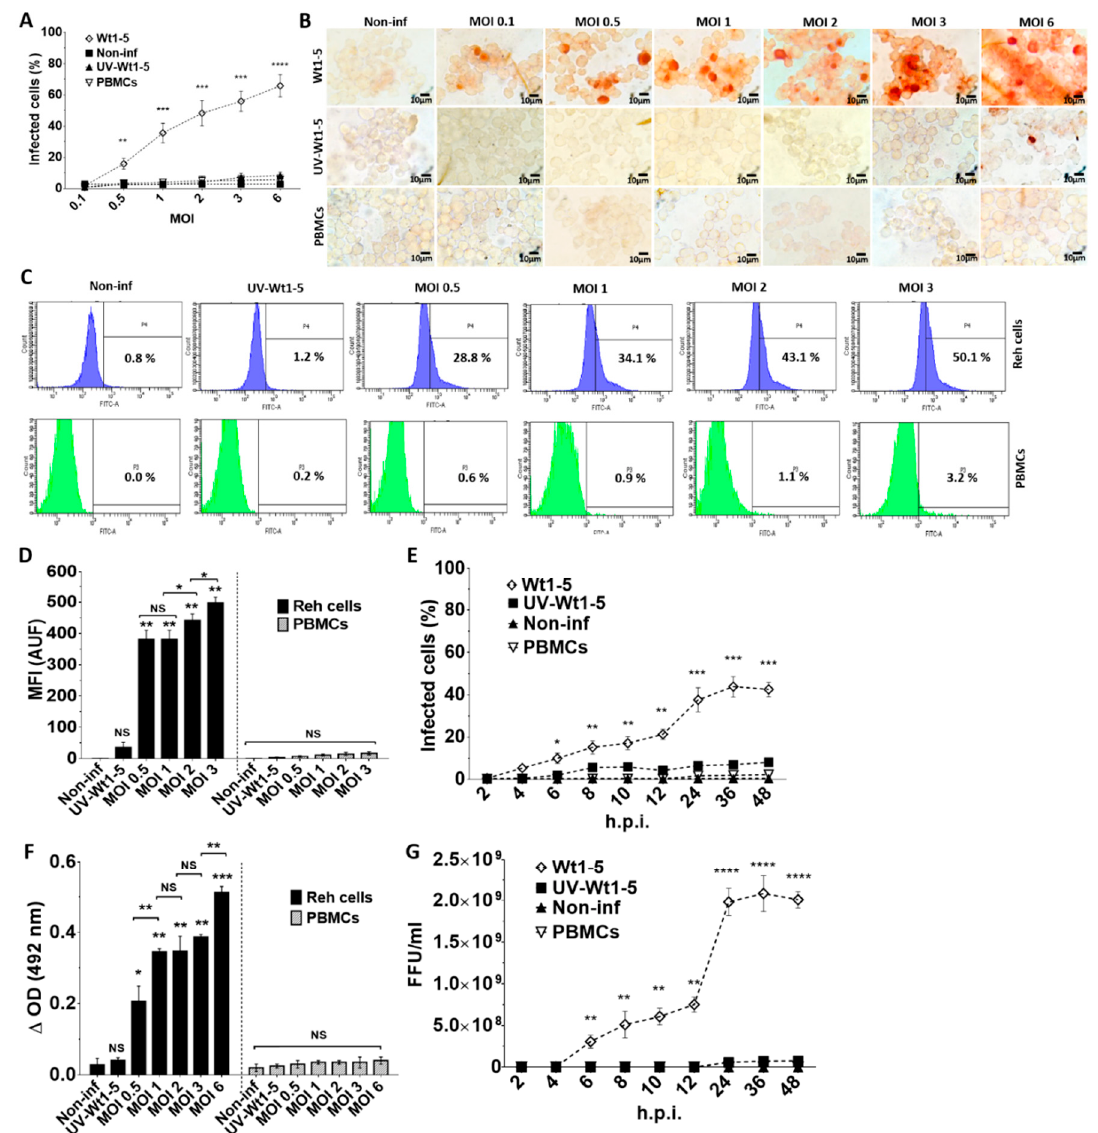
Figure 1. Infection of Reh cells and PBMCs by rotavirus isolate Wt1-5. Reh cells at a logarithmic growth phase were infected with trypsin-activated Wt1-5 (MOI 0.1 to 6) (or left uninfected) in RPMI culture medium without FBS. PBMCs were used as a control. UV-inactivated Wt1-5-infected cells were used as a control. ( A ) Samples of Reh cells and PBMCs were collected at 24 h.p.i. and subjected to immunochemistry assay using antibodies to rotavirus structural proteins. Percentages of infected cells at di ff erent MOIs are shown. ( B ) Representative photographs of immunochemistry assays at 24 h.p.i. at di ff erent MOIs are shown. ( C ) Flow cytometric analysis of Wt1-5-infected Reh cells and PBMCs for rotavirus antigen at di ff erent MOIs is depicted. ( D ) Quantification of fluorescence intensity in arbitrary units of fluorescence (AUF) for rotavirus antigens is shown for infected Reh cells and PBMCs ( E ) Immunocytochemistry analysis for rotavirus antigens of infected Reh cells and PBMCs at MOI 2 through the post-infection time (2 to 48 h) is shown. ( F ) ELISA results showing the presence of rotavirus antigens in the 700 g supernatant of infected Reh cells and PBMCs at 24 h.p.i. are shown. ( G ) Infection of Reh cells and PBMCs with trypsin-activated 700 g supernatants obtained from lysates of previously infected cells taken at the post-infection times indicated in ( E ). Virus titers (FFU / mL) were determined by immunochemistry at 12 h.p.i. Data are presented as mean ± SD of three independent experiments performed in duplicate. Statistical significance is indicated by p -values (**** p ≤ 0.001, *** p ≤ 0.01, ** p ≤ 0.05, and * p ≤